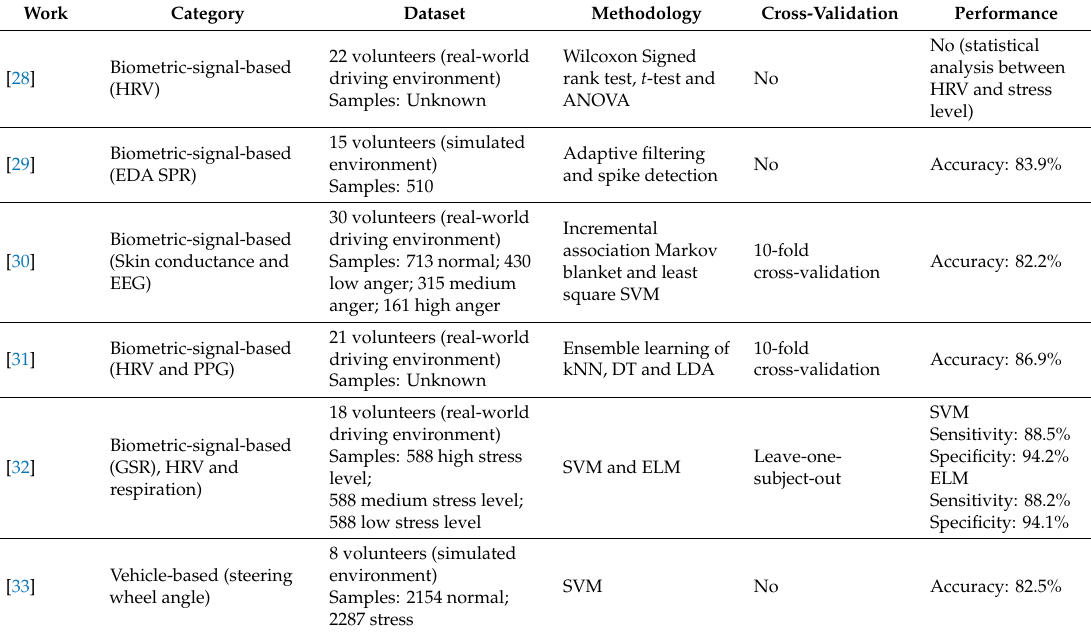
Table 3. Performance comparison between the proposed method and existing works for driver stress